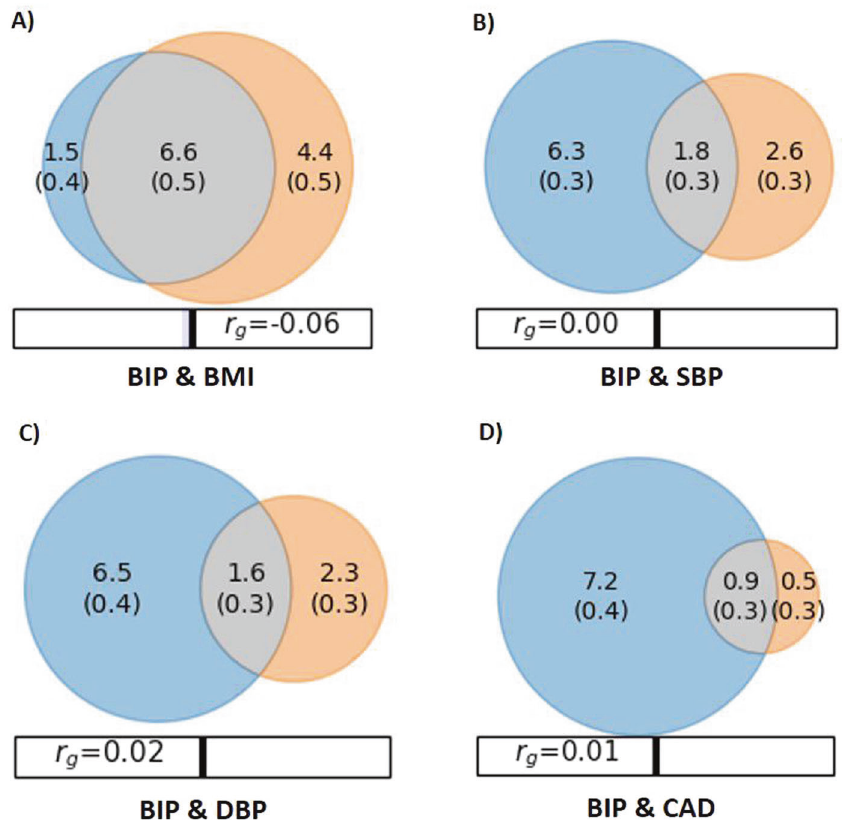
Fig. 1 Venn diagrams of shared and unique polygenic variants. Venn diagrams of shared and unique trait-in fl uencing variants, showing polygenic overlap (gray) between bipolar disorder (BIP) (blue) and ( A ) body mass index (BMI) (orange), ( B ) systolic blood pressure (SBP) (orange), ( C ) diastolic blood pressure (DBP) (orange), and ( D ) coronary artery disease (CAD) (orange). The numbers in the Venn diagram indicate the estimated quantity of shared and unique trait-in fl uencing variants (in thousands), explaining 90% of SNP heritability in each phenotype, followed by standard error. The size of the circles re fl ects the degree of polygenicity. The fi gure is based on MiXeR